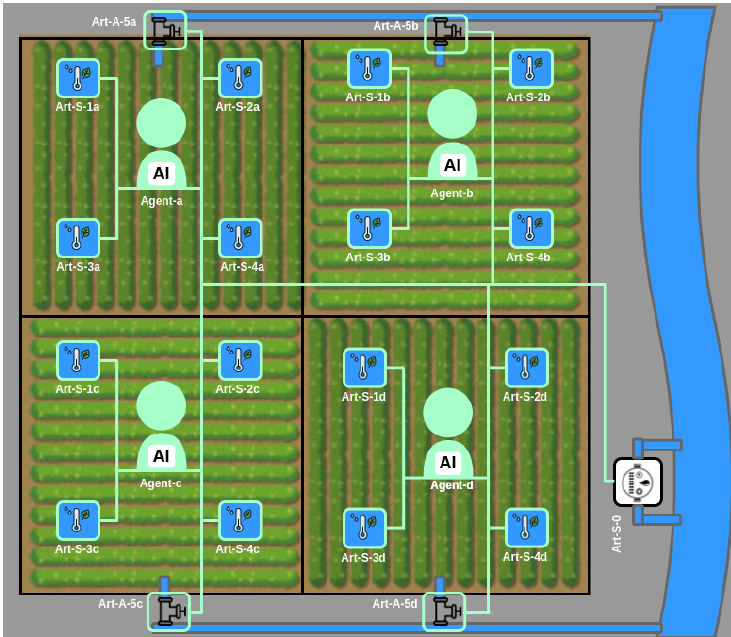
Figure 8. General view of the proposed case study.